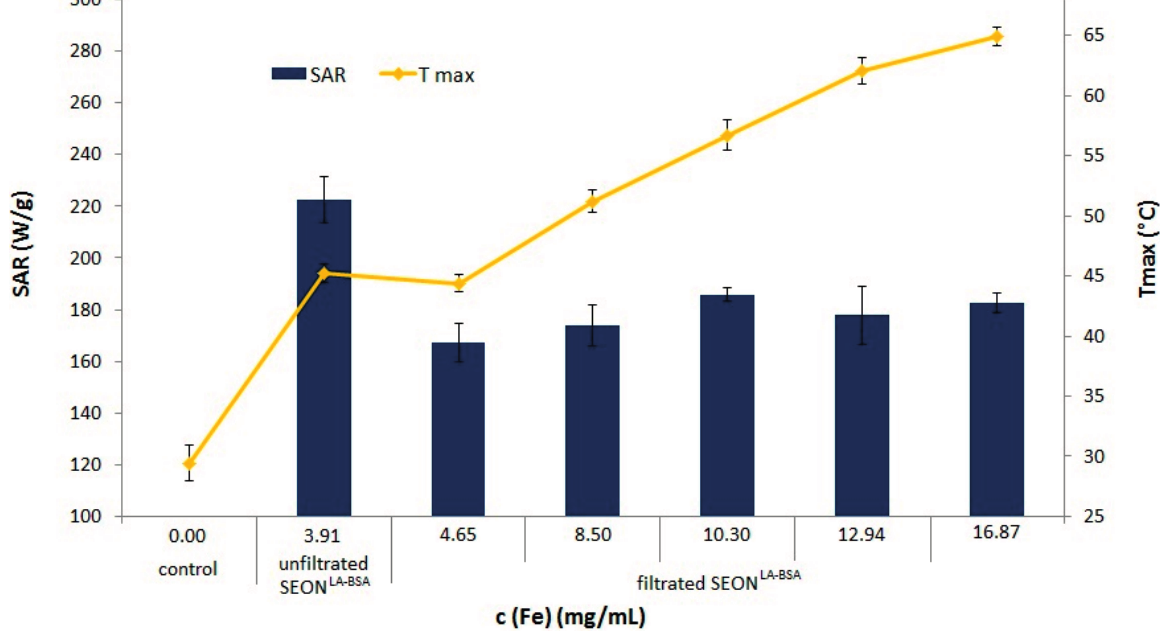
Figure 8. SAR and T max of SEON LA-BSA after filtration and/or concentration. Specific absorption rates (blue bars) and maximum heating temperatures (yellow dots) of un-filtrated SEON LA-BSA and filtrated and concentrated SEON LA-BSA . All measurements were performed in